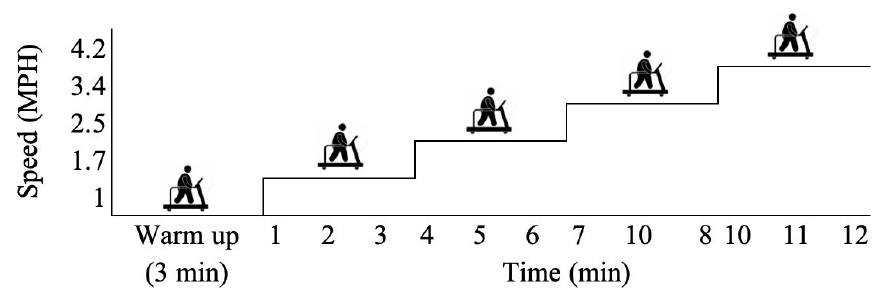
Figure 1. Modified Bruce submaximal treadmill protocol.